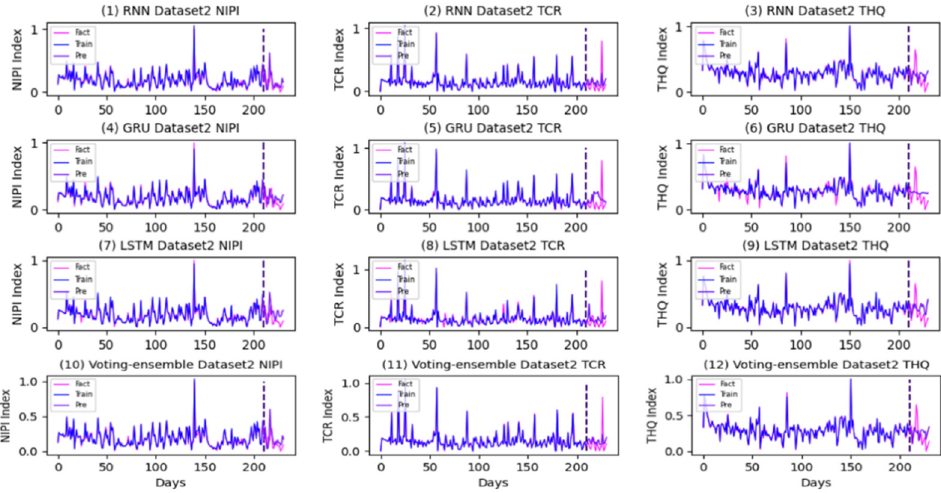
Figure 17. Prediction and actual curves generated using the RNN, GRU, LSTM, and the proposed method in Dataset2.